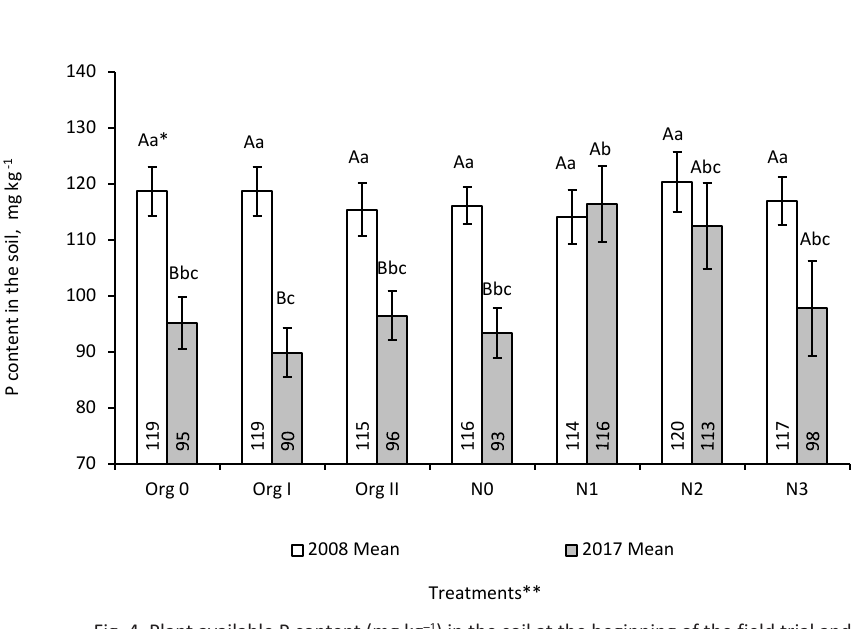
Fig. 4. Plant available P content (mg kg –1 ) in the soil at the beginning of the field trial and after ten years. 2008 Mean: F =1.268, p =0.276; 2017 Mean: F =2.754, p =0.0149; (6, 133) (6, 133) *different large letters indicate a significant difference between years, and different small letters indicate the difference between treatments in a given year; **See explanations under Figure 1